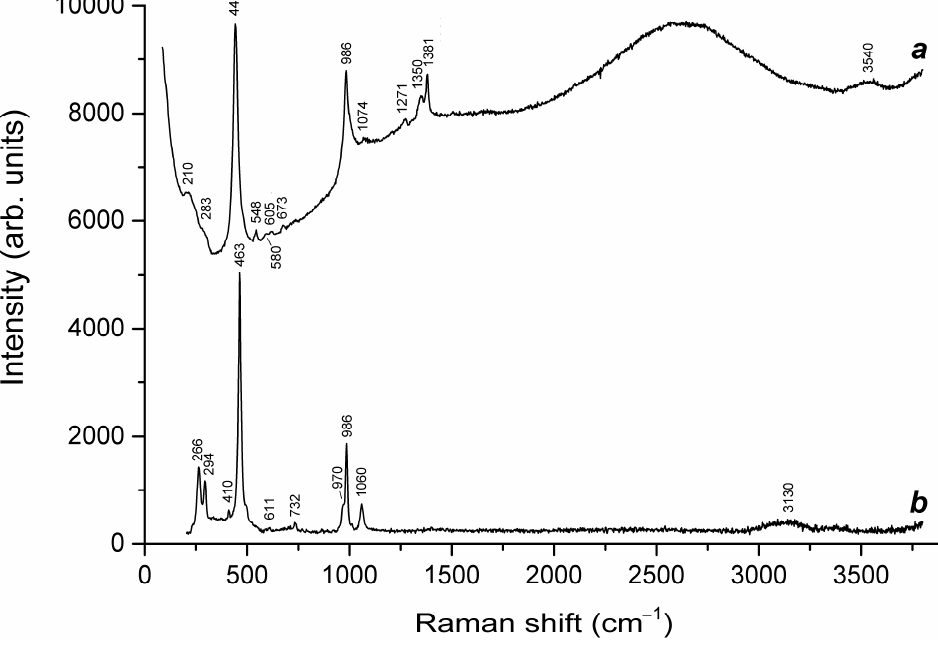
Figure 3. Raman spectra of ( a ) sapozhnikovite (Sample 8) and ( b ) nosean (Sample 7). The assignment of bands in the Raman spectra of cubic sodalite-group minerals shown in Figures 1–3 (Table 2) was made in accordance with [3,4,38–50]. Table 2. Assignment of Raman bands of cubic sodalite-group minerals. Raman Shift (cm −1 )